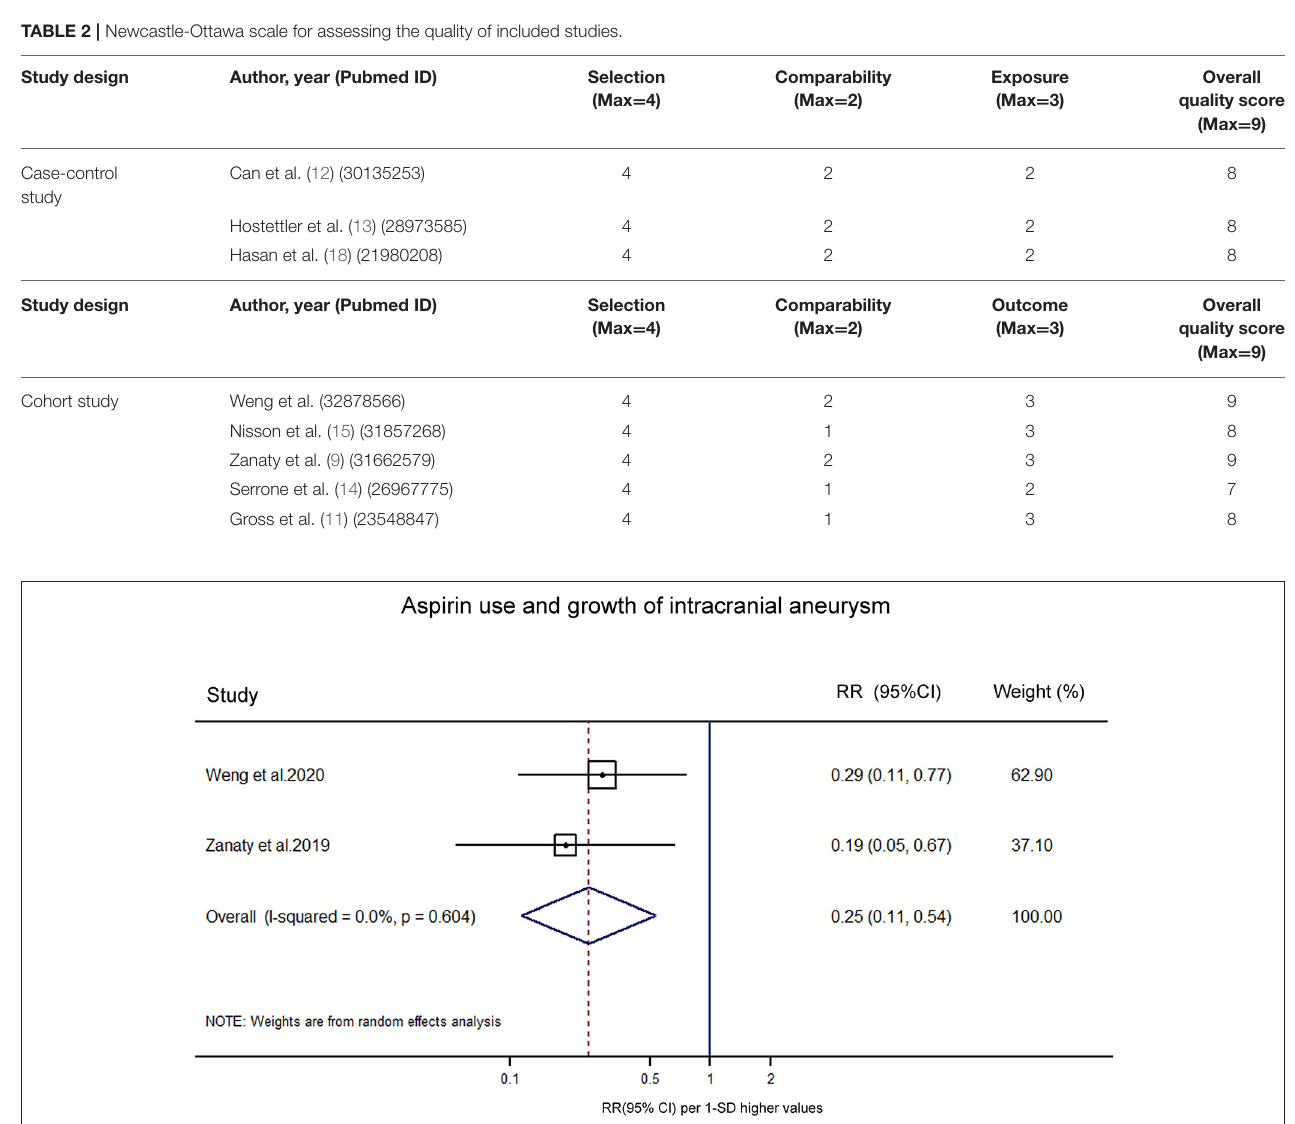
FIGURE 2 | Forest plot for an association between aspirin use and growth of intracranial aneurysm. OR, odds ratio; CI, confidence